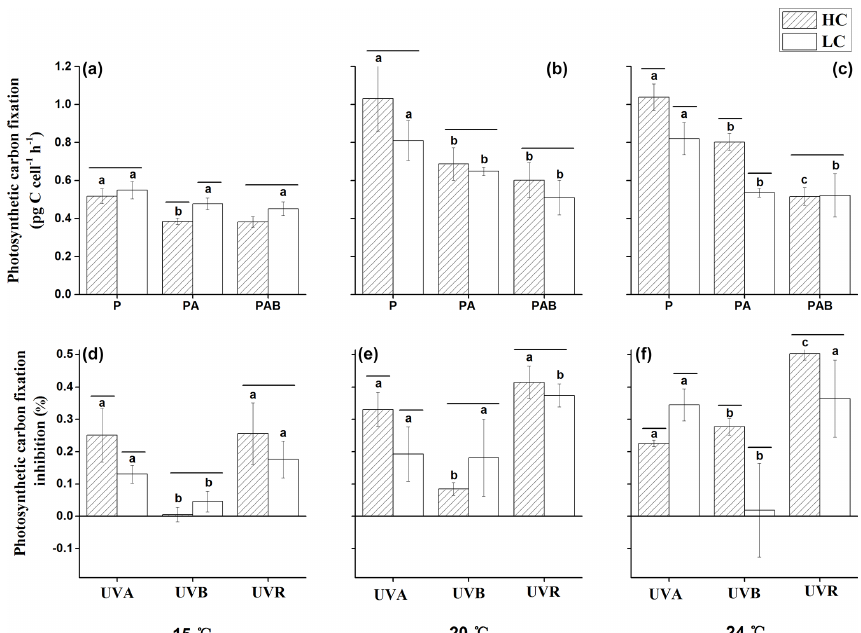
Figure 5. Photosynthetic carbon fixation rates (a–c) under P (irradiances above 395nm), PA (irradiances above 320nm) and PAB (irradiances above 295nm), and inhibition of photosynthetic carbon fixation rates (d–f) due to UVA, UVB and UVR of E. huxleyi in HC- and LC-grown cells at 15, 20 and 25 ◦ C . Lines above the histogram bars indicate significant differences between the HC and LC treatments, and the different letters indicate significant differences among the radiation treatments within the HC- or LC-grown cells within each